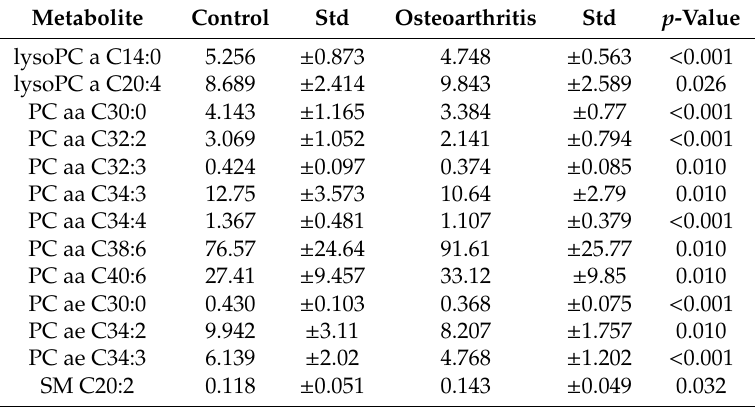
Table 3. Complex lipid profile of the osteoarthritis and the control group.